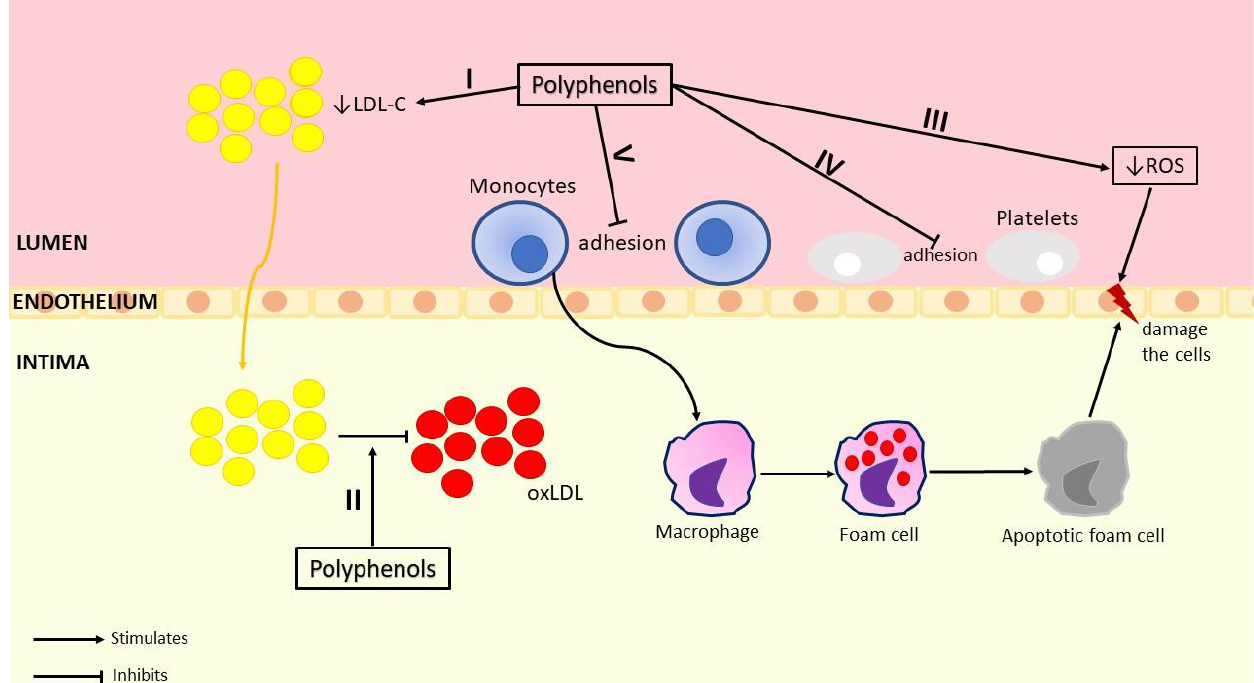
Figure 3. Anti-atherogenic effect of polyphenols from grape pomace (I — Polyphenols reduce LDL levels; II — Polyphenols reduce oxLDL formation; III — Polyphenols reduce ROS production; IV — Polyphenols inhibit platelets activation and adhesion by blocking its agonists; V — Polyphenols reduce monocytes adhesion by reducing the expression of VCAM-1).